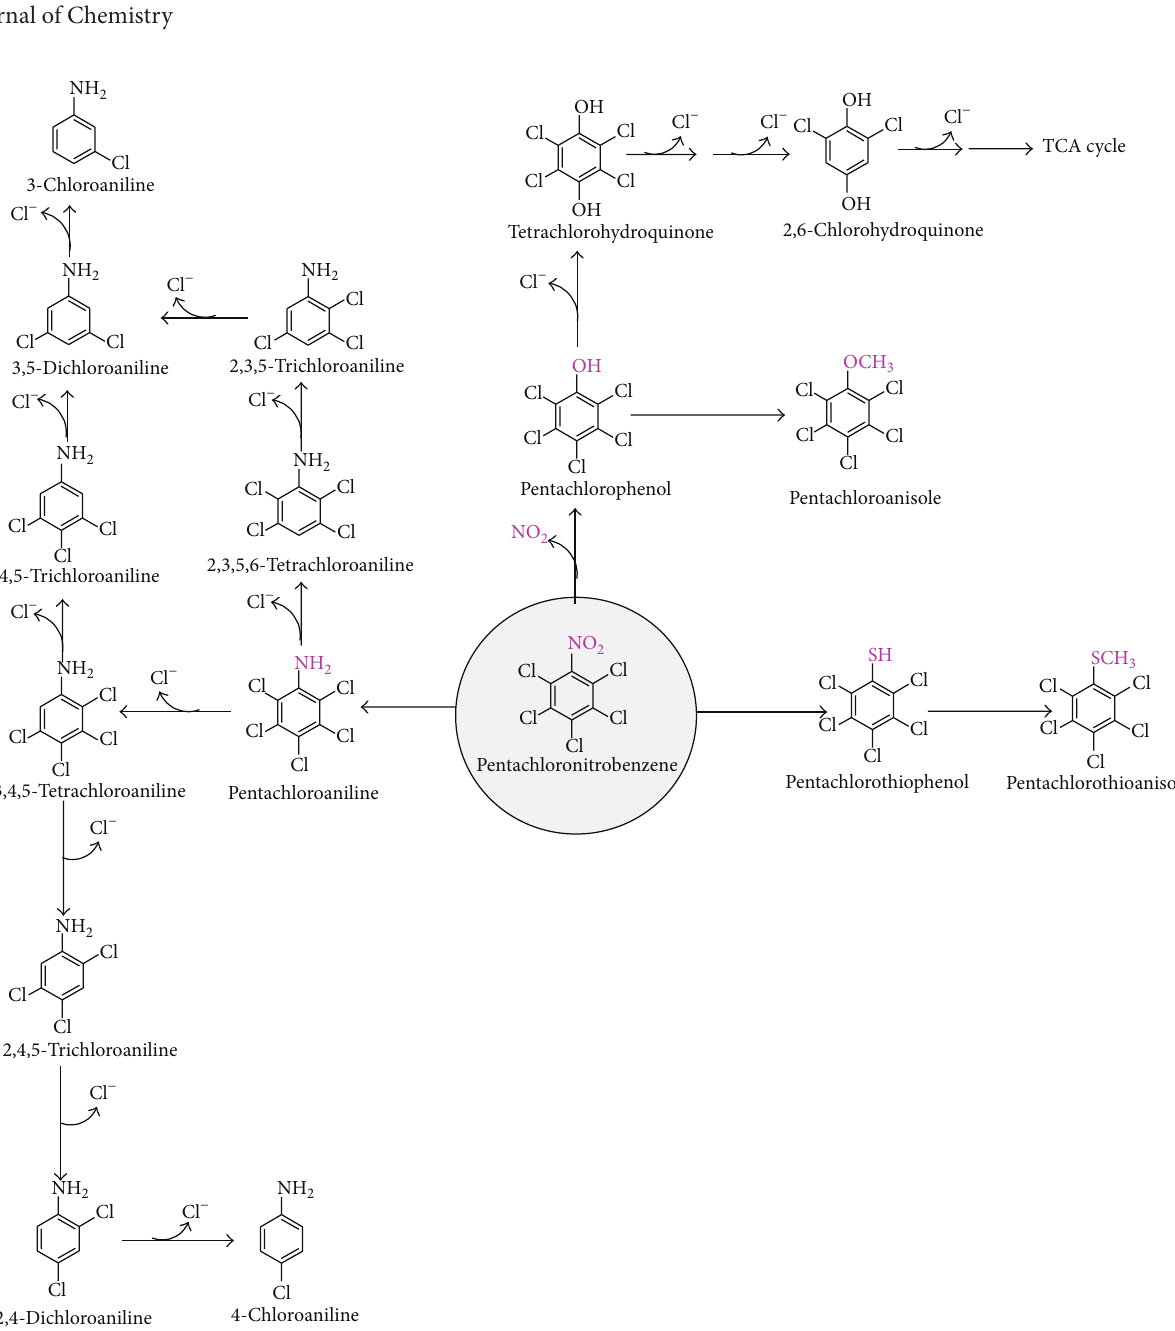
Figure 5: Degradation pathways of pentachloronitrobenzene (adapted from Arora et al.